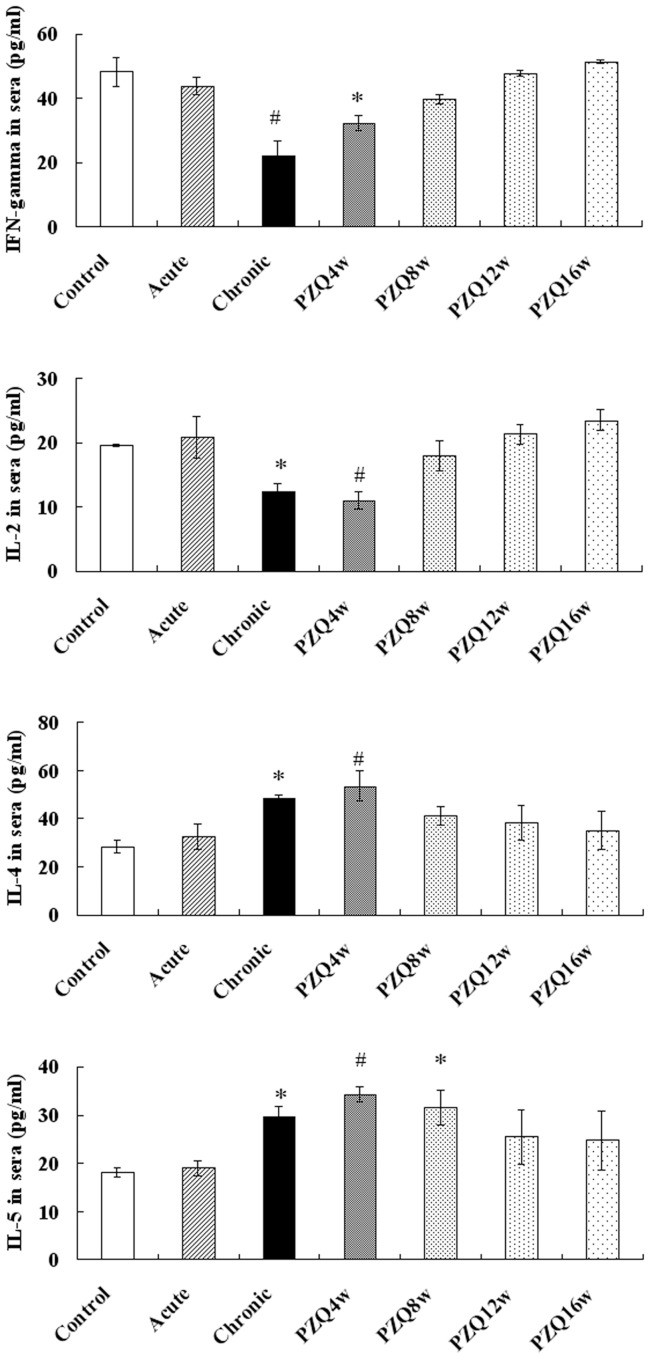
Th1 and Th2 cytokines in sera of mice.The levels of IFN-γ IL-2, IL-4, and IL-5 were determined in individual sera (n = 10 mice/group) by commercially available ELISA kits. The experiment was performed twice and each value shown represents the mean and SE of 20 value. * P<0.05 versus control group. # P<0.01 versus control group.